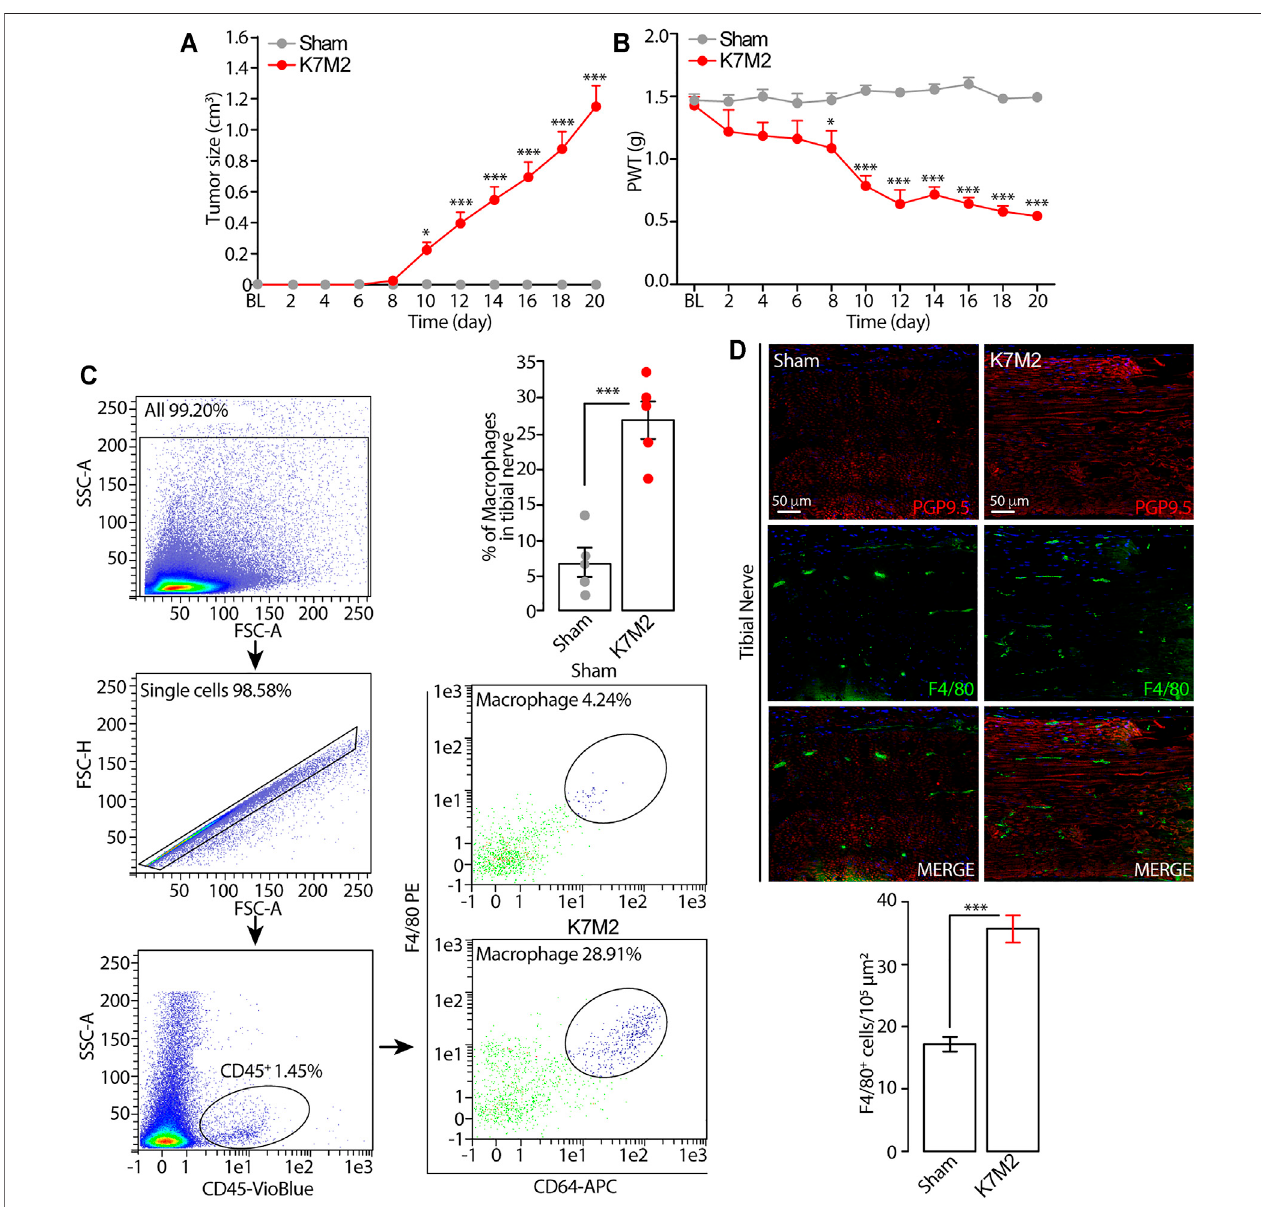
FIGURE 1 | Tumor growth and mechanical allodynia induced by K7M2 osteosarcoma cells in BALB/c mice (A and B) Time dependent increase in tumor size and mechanical allodynia after para-tibial K7M2 osteosarcoma cell inoculation or sham in BALB/c mice (C) Representative gating strategy of fl ow cytometry analysis and relative quanti fi cation of F4/80 + /CD64 + monocytes/macrophages in tibial nerve, and (D) typical images and pooled data of F4/80 + cells in the ipsilateral tibial nerve (stained with the neural marker PGP9.5) after para-tibial K7M2 osteosarcoma cell inoculation or sham in BALB/c mice. BL, baseline. PWT, paw withdrawal threshold.N (cid:2) 6mice.* p < 0.05,*** p < 0.001K7M2vsSham.Dataarepresentedasmean ± SEM,datapointsoverlaid(C,D).Two-wayANOVAandBonferroniposthoc test (A, B), unpaired student t-test (C,